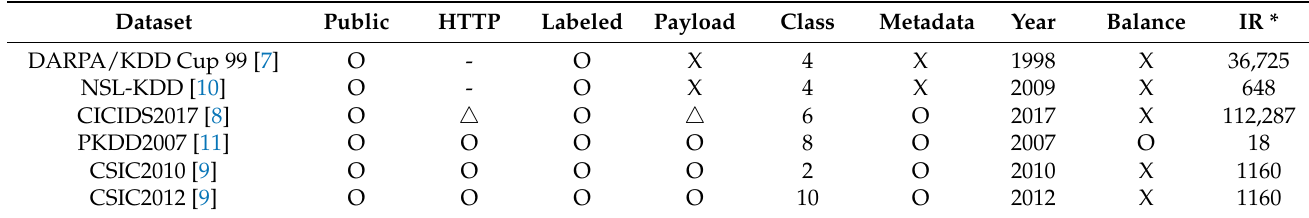
Table 2. Comparison of intrusion detection